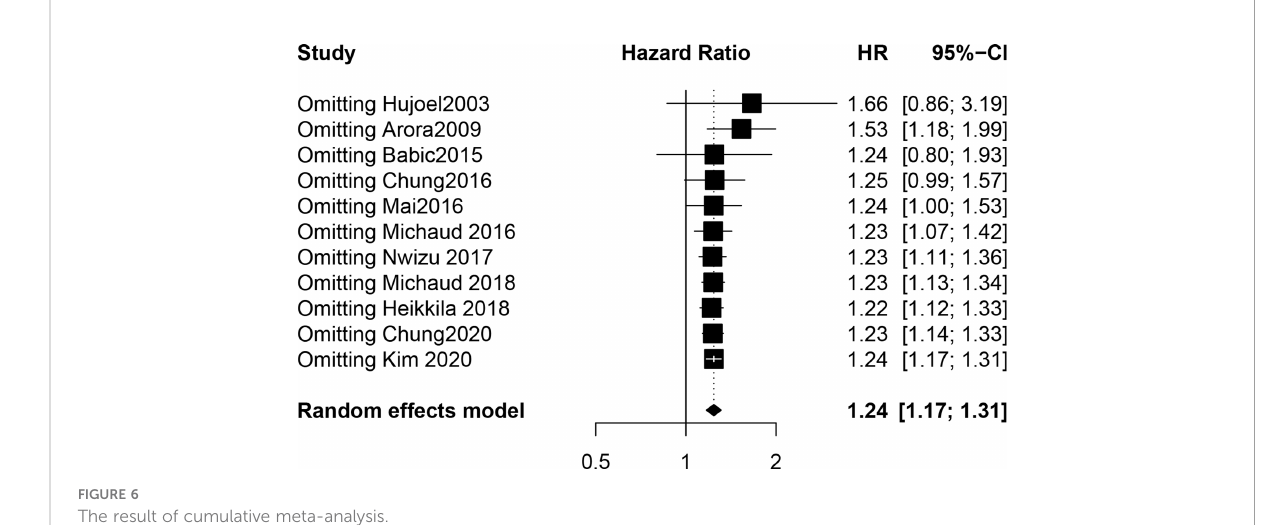
FIGURE 6 The result of cumulative